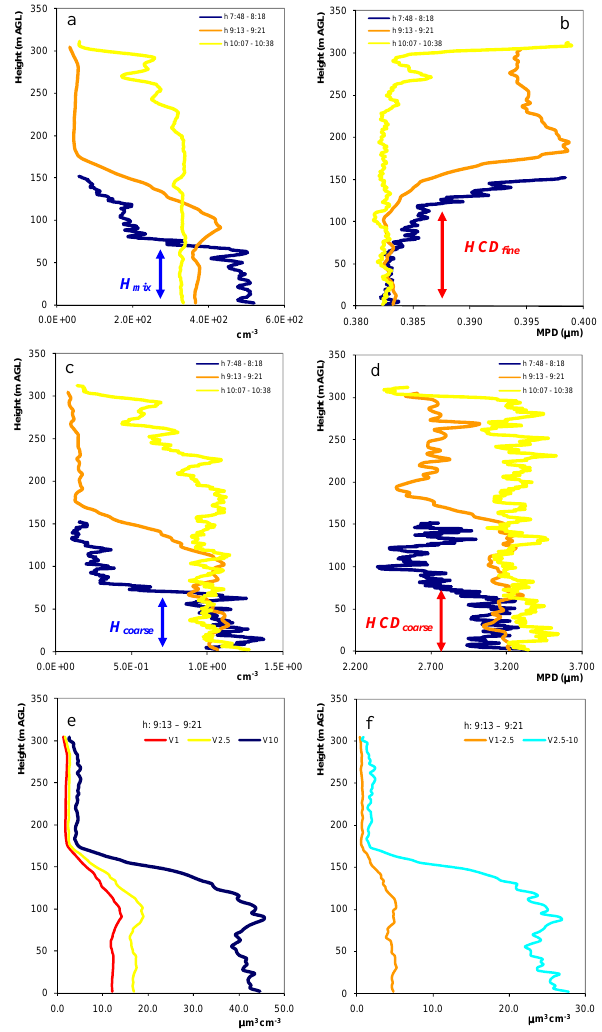
Fig. 2. Selected profiles of particle number concentration, mean particle diameter (MPD) and volume concentration over Torre Sarca on 20 th December 2005. Particle number concentration profiles are plotted for fine particles ( d p < 1.6µm) and coarse particles ( d p > 1.6µm) respectively in panels (a) and (c) ; mean particle di- ameter (MPD) behaviour along height is plotted for fine and coarse particles respectively in panels (b) and (d) . H mix and H coarse re- fer to the heights calculated from the observed vertical concentra- tion gradient for fine and coarse particles of the two-size fraction, respectively. HCD fine and HCD coarse refer to the heights calcu- lated from the observed vertical MPD gradient for fine and coarse particles respectively. Finally, the profiles of volume concentration V 1 , V 2 . 5 and V 10 (respectively with d p less than 1µm, 2.5µm and 10µm), and their in-between V 1 − 2 . 5 and V 2 . 5 − 10 , are plotted, re- spectively, in panels (e) and (f) ; they refer to the “h: 9:13–9:21” balloon flight of the 20th December